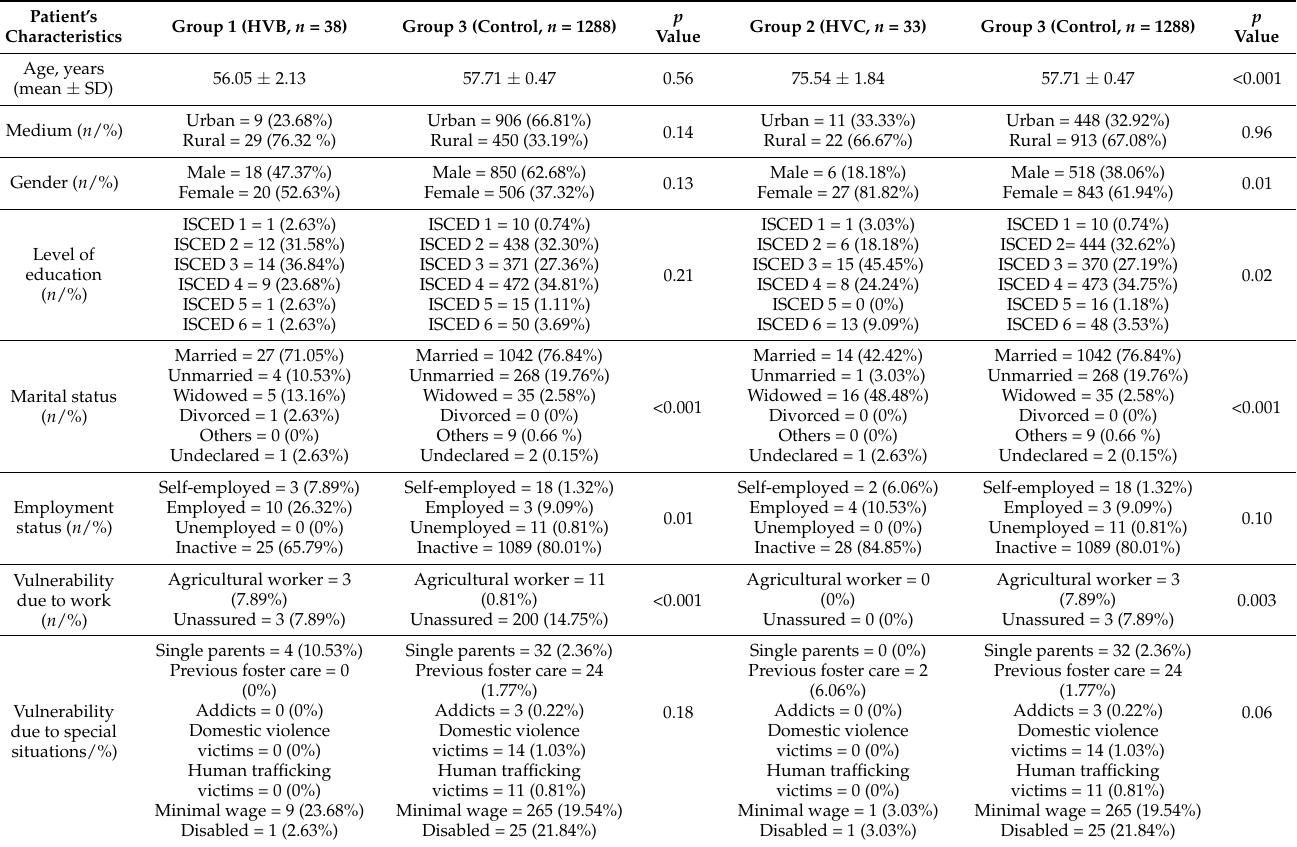
Table 1. Demographic characteristics of the patients included in the main